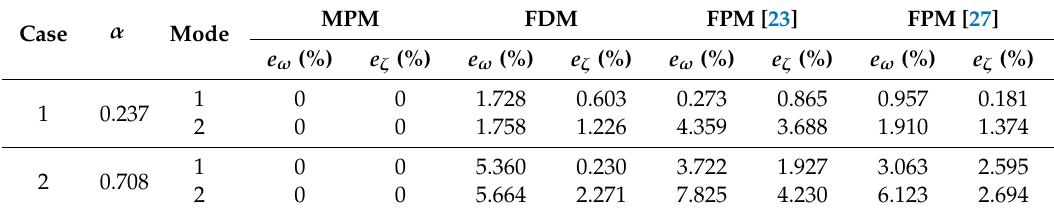
Table 3. The coupling index α and relative error e of the 2-DOFs